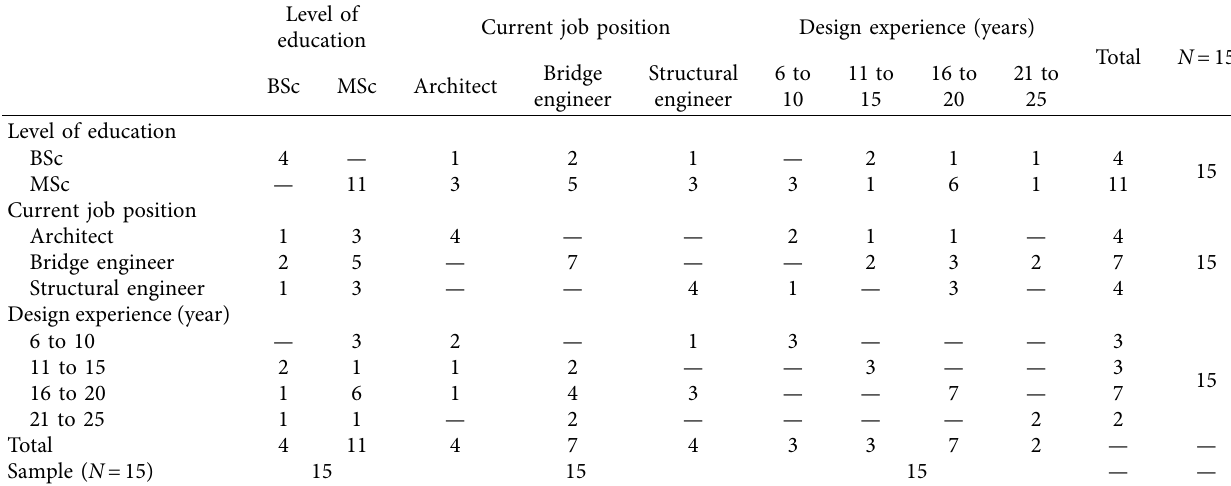
Table 2: Demographic distribution of